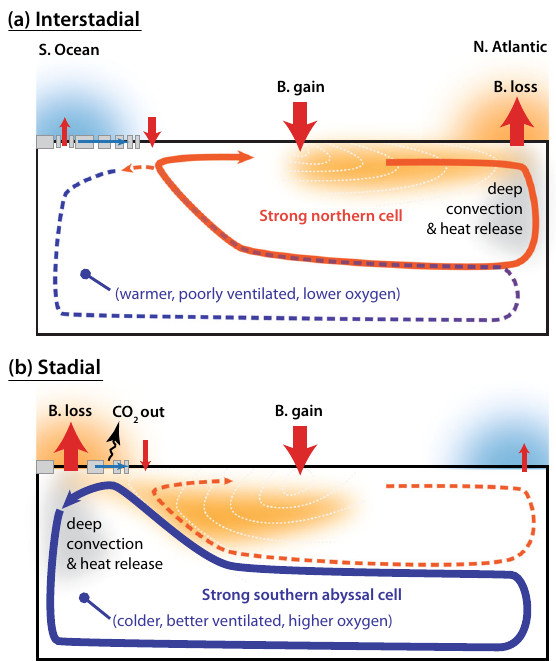
Fig. 5 Schematic of the bipolar ‘ ventilation seesaw ’ concept. An alternating dominance of buoyancy (and heat) loss from the North Atlantic (right) and Southern Ocean (left), balances buoyancy and heat input at low latitudes, for a Greenland-interstadial, and b Greenland-stadial conditions. Enhanced air – sea exchange associated with water-mass conversion in the Southern Ocean enhances heat- and carbon loss from the southern abyssal cell, and increases its oxygen and radiocarbon content (note that the northern cell will typically remain warmer and better ventilated than the abyssal southern cell). Red arrows at the ocean surface indicate buoyancy fl uxes of different approximate magnitudes. Weakened overturning cells are indicated by dashed continuous arrows; strengthened cells by heavy solid continuous